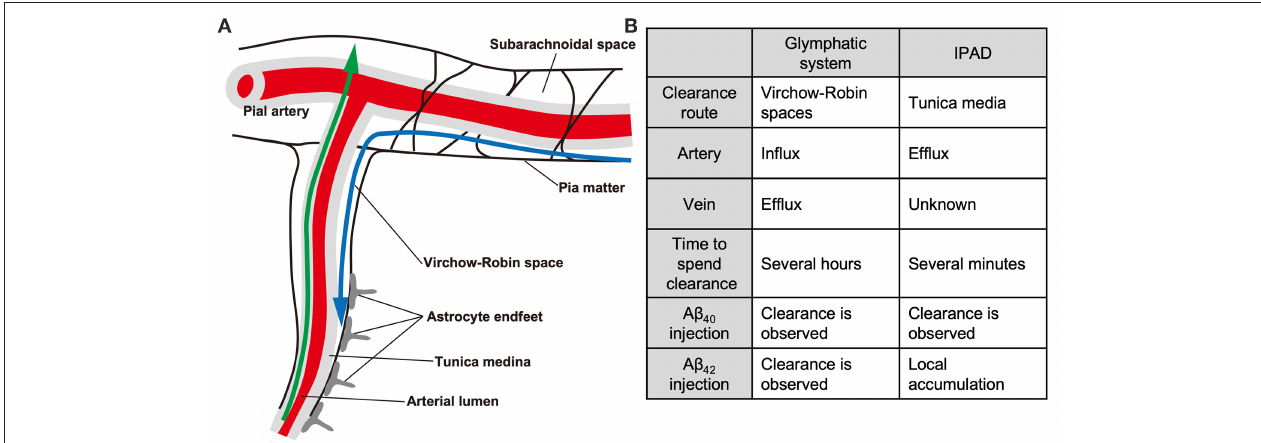
FIGURE 1 | The glymphatic and IPAD systems. Schematic (A) and differences (B) of the glymphatic and IPAD systems. Note that the directions of the two clearance systems are the opposite. Blue, glymphatic system; green, IPAD. The IPAD is a more rapid clearance system than the glymphatic system. Note the differences in the tracer distribution pattern after fluorescent A β 40 and A β 42